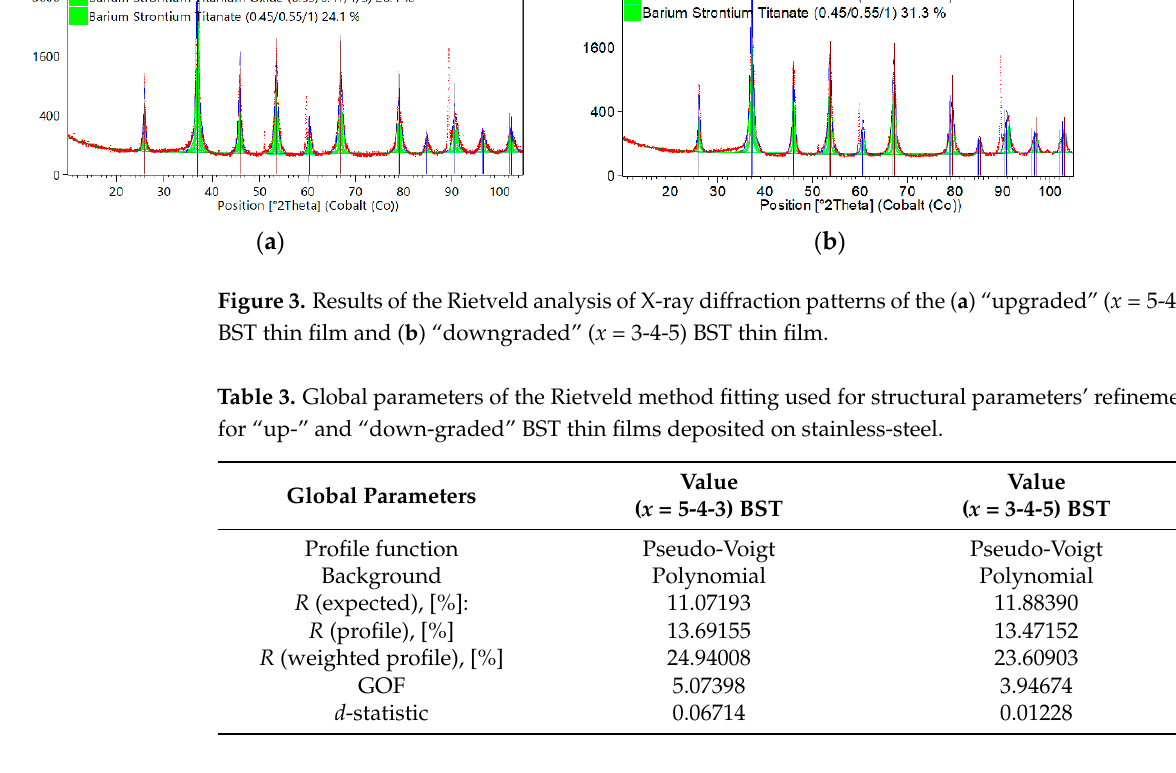
Table 4. Relevant parameters of the BST phases identified for “upgraded” ( x = 5-4-3) (left side of the column) and “downgraded” ( x = 3-4-5) (right side of the column) BST thin film. Table 3. Global parameters of the Rietveld method fitting used for structural parameters’ refinement Barium Strontium Titanate for “up-” and “down-graded” BST thin films deposited on stainless-steel.